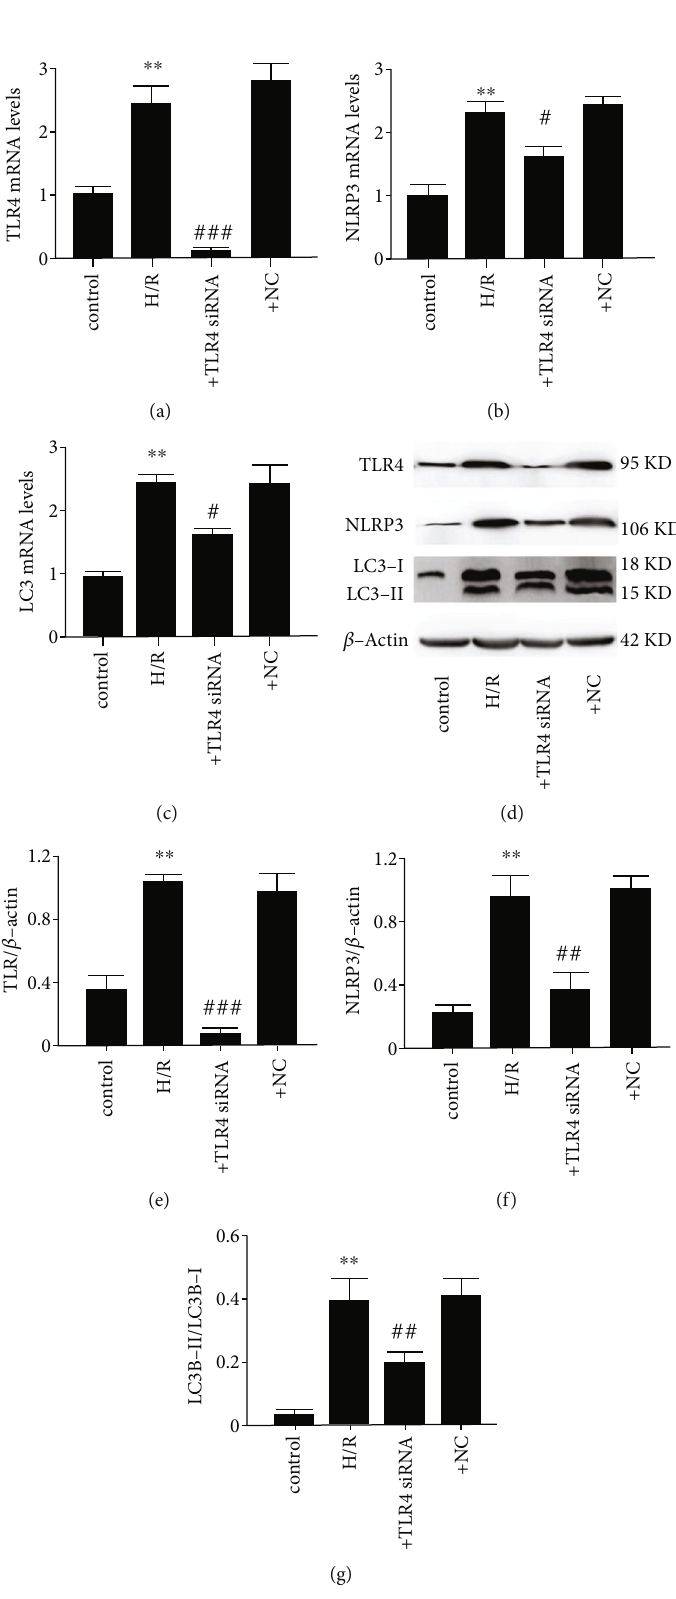
Figure 4: TLR4 knockdown suppresses rises in NLRP3 and LC3 in H/R-induced SH-SY5Y cells. (a) TLR4 mRNA level. (b) NLRP3 mRNA level. (c) LC3 mRNA level. (d) protein expression level. (e) The ratio of TLR4 to β -actin. (f) The ratio of NLRP3 to β -actin. (g) The ratio of LC3-I to LC3-II. The data expressed as mean ± SD . +TLR4 siRNA: cells treated with siRNA against TLR4 (100nm); +NC siRNA: cells with negative control siRNA (100nm). ∗∗ P < 0 : 05 vs. control; # P < 0 : 05 vs. H/R; ## P < 0 : 01 vs. H/R; ### P < 0 : 001 vs.